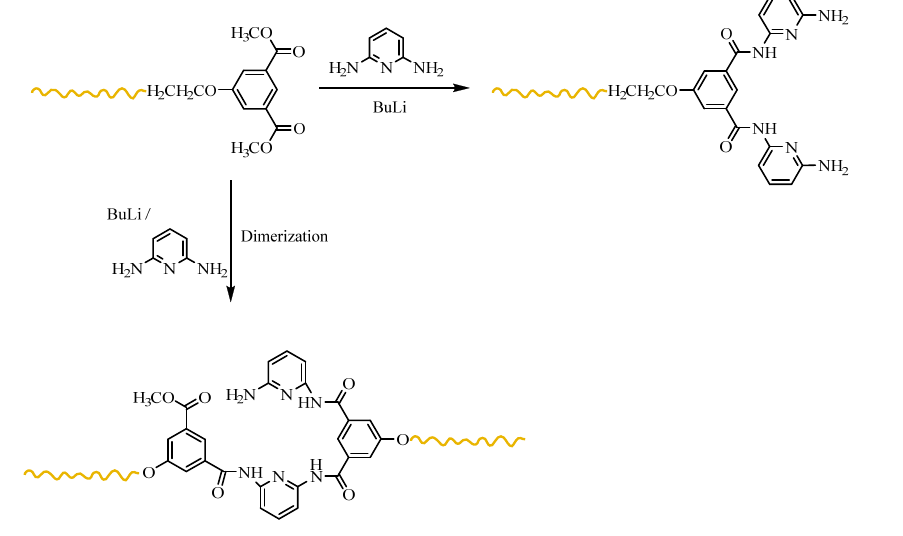
Scheme 2. Synthetic route for PS ‐ Ham (6).